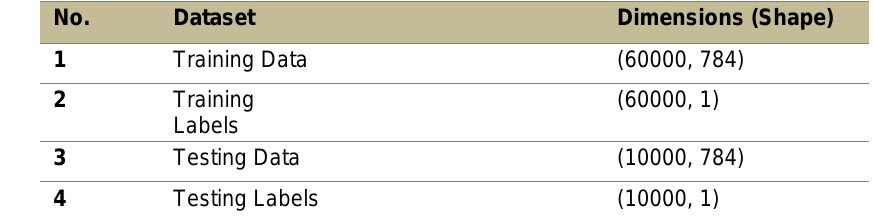
Table 1 – Dimensionality of the MNIST training and testing dataset